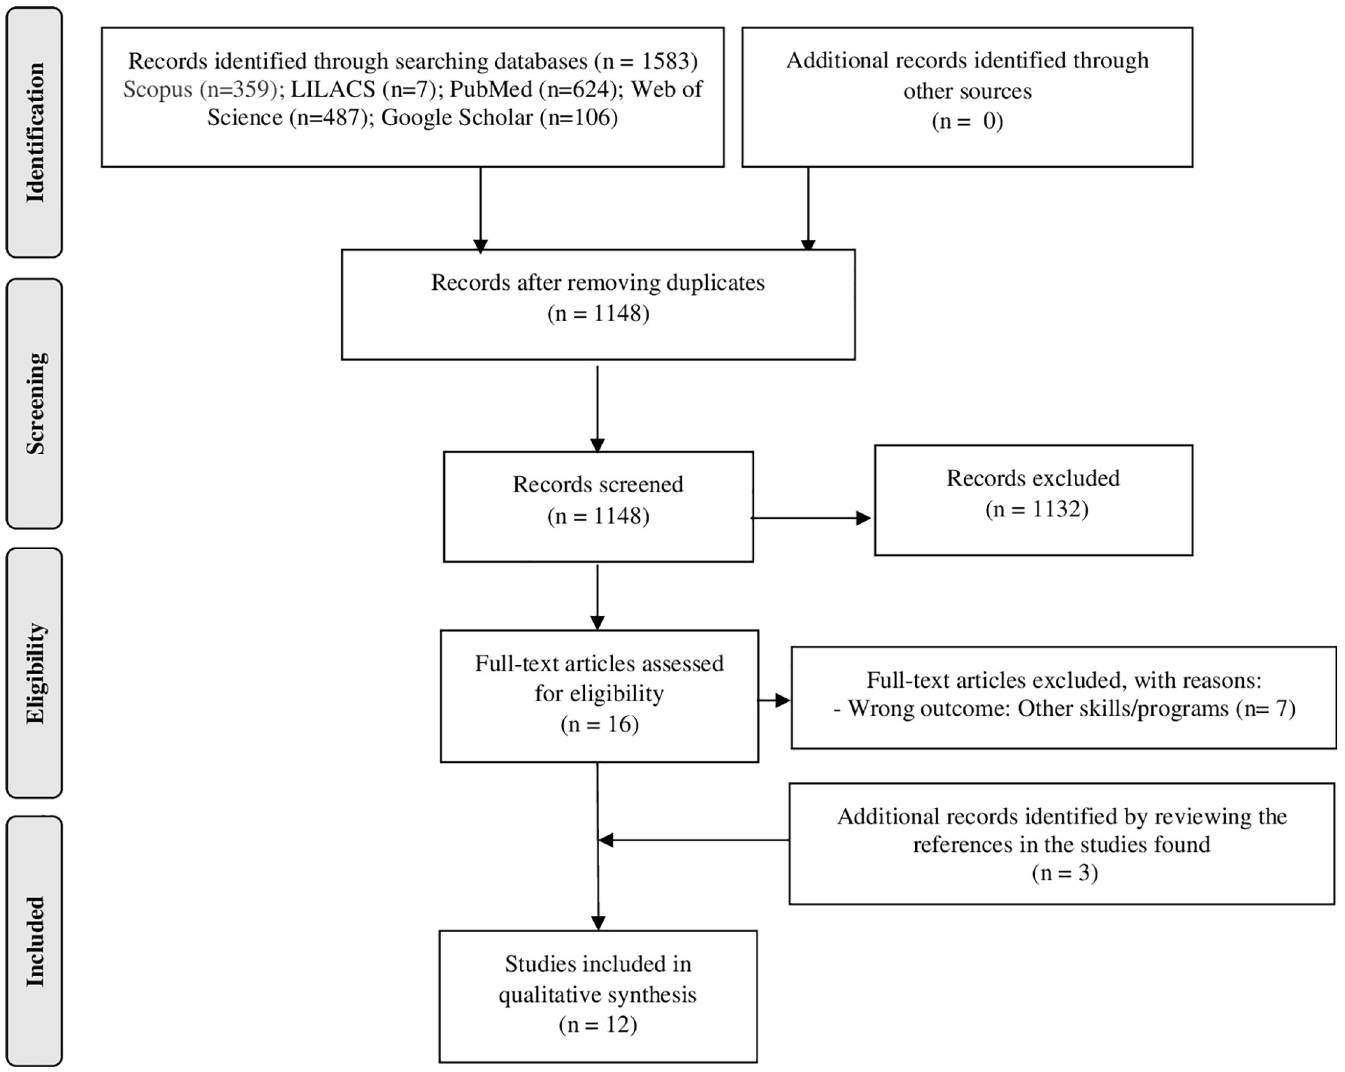
Fig 1. Study selection flowchart of literature search. Abbreviations LILACS: Latin American and Caribbean Health Sciences Literature.